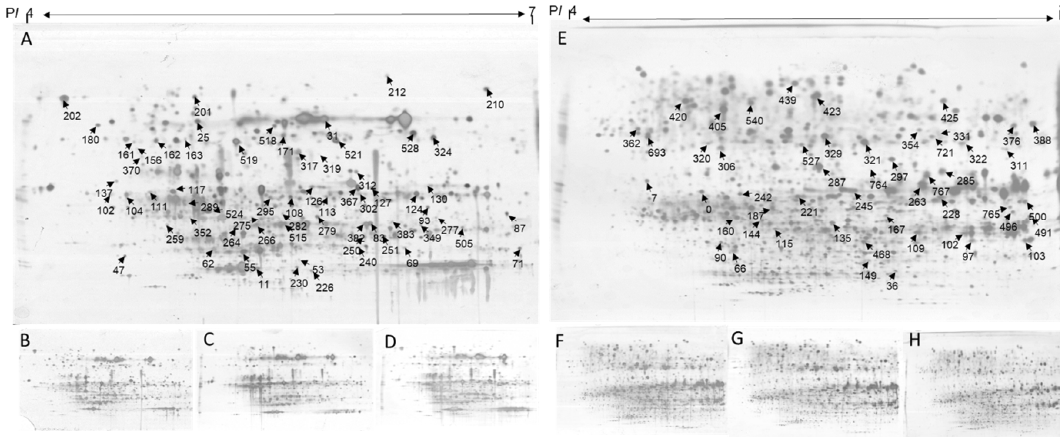
Figure 6. 2 ‐ DE gels from leaves ( A , B , C , D ), roots ( E , F , G , H ) show the positions of spots listed in Table S1 and Table S2. Arrow indicate salt ‐ responsive spots of which have been identified by MS. A: N33 leaves after exposure to 300 mM NaCl 4 days; B: T46 leaves after exposure to 300 mM NaCl 4 days; C: N33 leaves under control conditions; D: T46 leaves under control conditions; E: N33 roots after